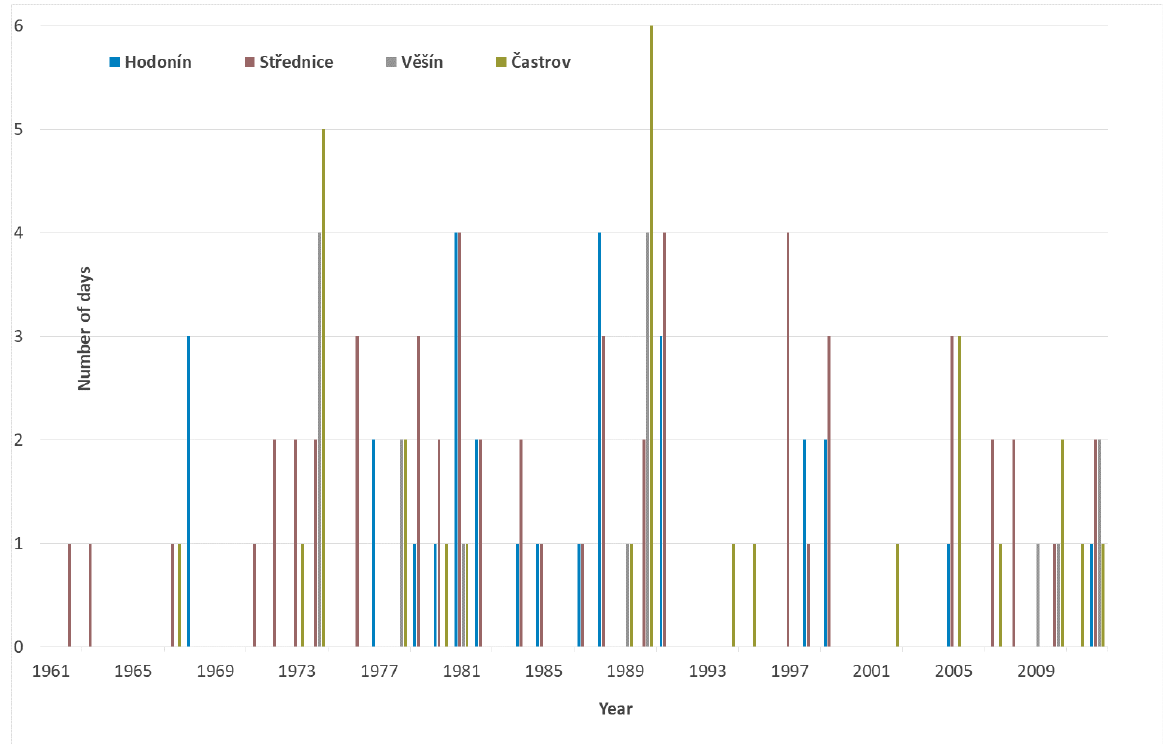
Figure 4. Number of days with Tmin < −1 .1 °C during the period of the cherry tree flowering in the period of 1961 – 2012.